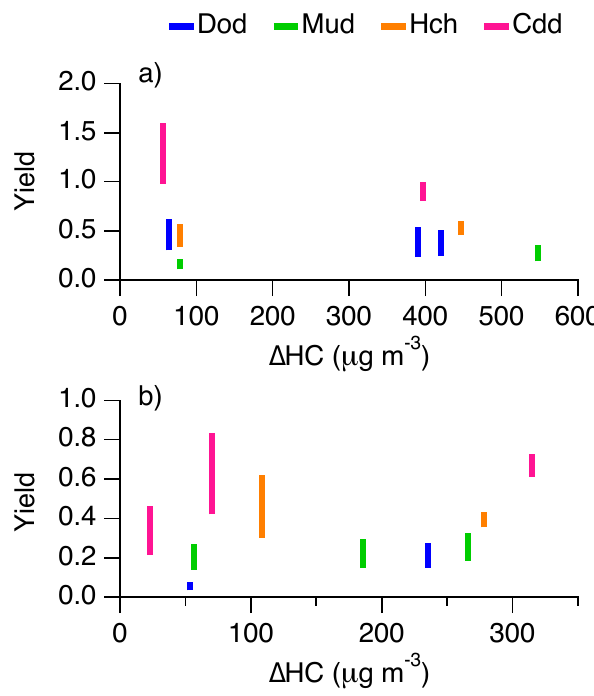
Fig. 2. SOA yield at 95–100% of initial hydrocarbon reacted under (a) high- and (b) low-NO x conditions. Each line shows the range between the lower limit (deposited particles do not undergo gas- particle partitioning) and upper limit (gas-particle partitioning to deposited particles is the same as that to suspended particles) SOA yields for an